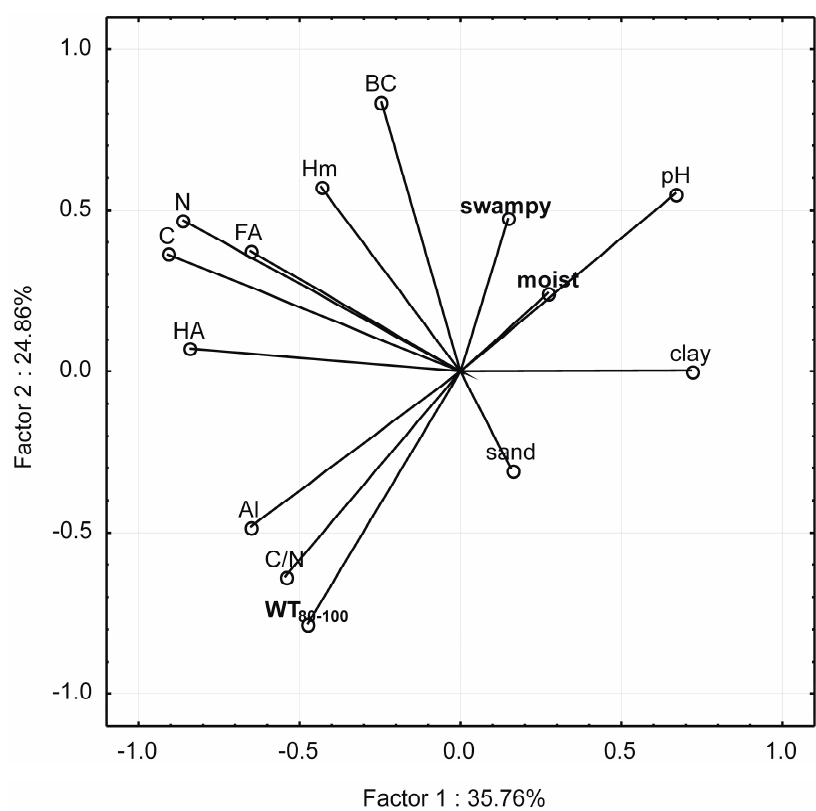
Figure 3. Diagram of Principal Components Analysis (PCA) with projection of variables on a plane of the first and second factor in the surface horizon (WT 80–100 , moist and swampy—soil moisture gradient; HA—humic acids, FA—fulvic acids, Hm—humins).